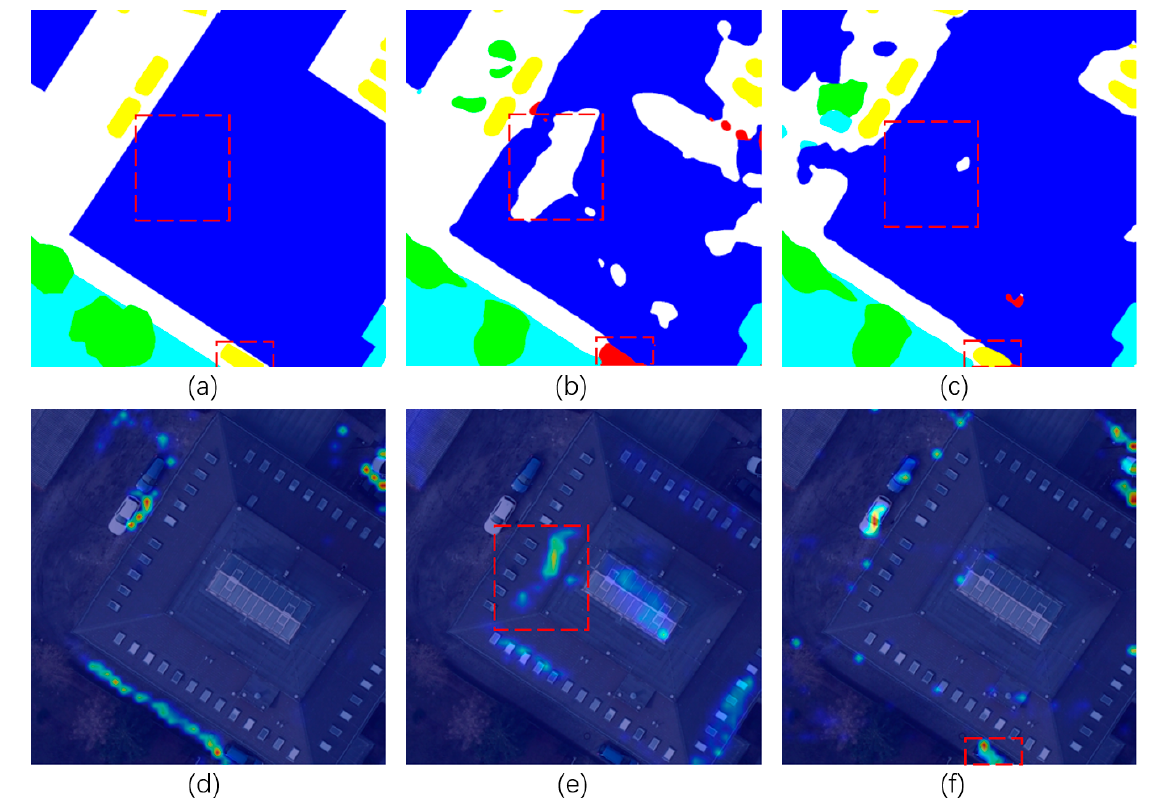
Figure 10. Visualization of LAM attention map. ( a ) label, ( b ) PAM + LAM result, ( c ) TANet result, ( d ) imperious surface attention map, ( e ) building attention map, ( f ) car attention map.